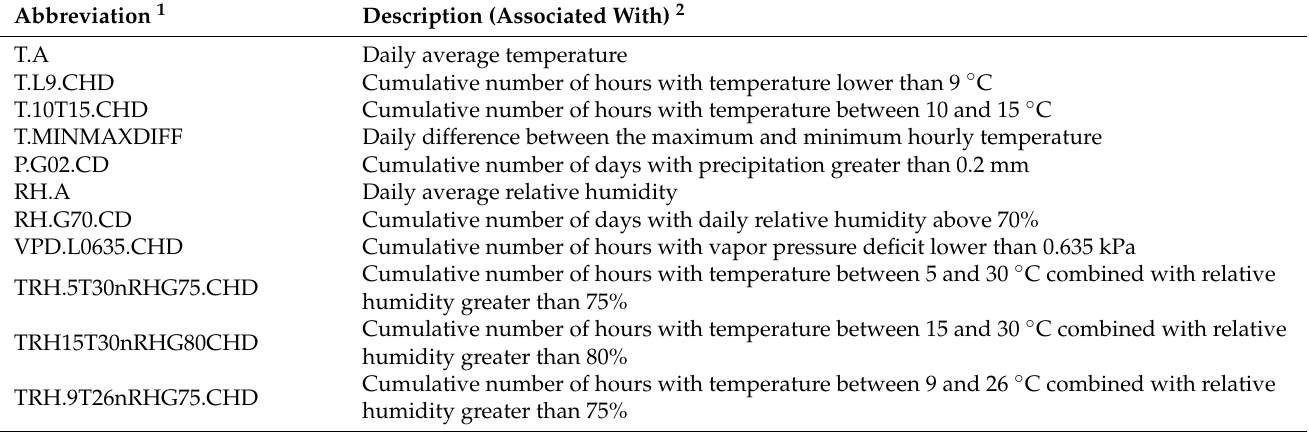
Table 2. Weather variables selected for use in the functional data